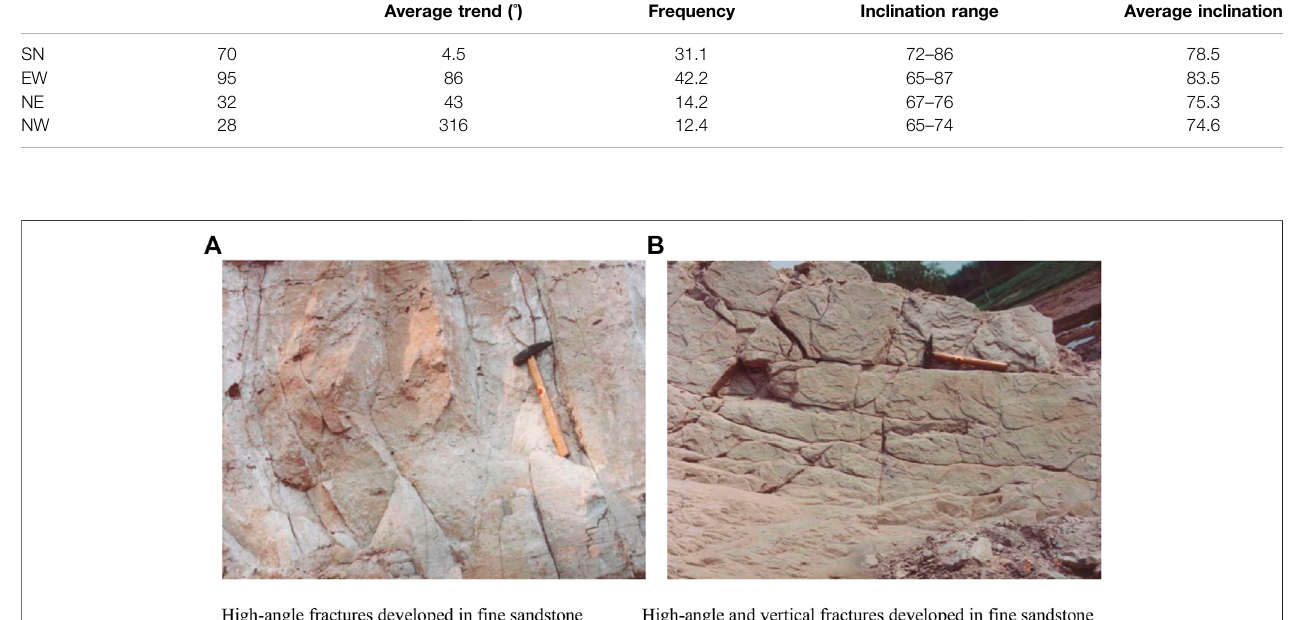
FIGURE1| Fractureinclinationobservedbysimilaroutcrops. (A) High-anglefracturesdevelopedin fi nesandstone. (B) High-angleandverticalfracturesdeveloped in fi ne sandstone.